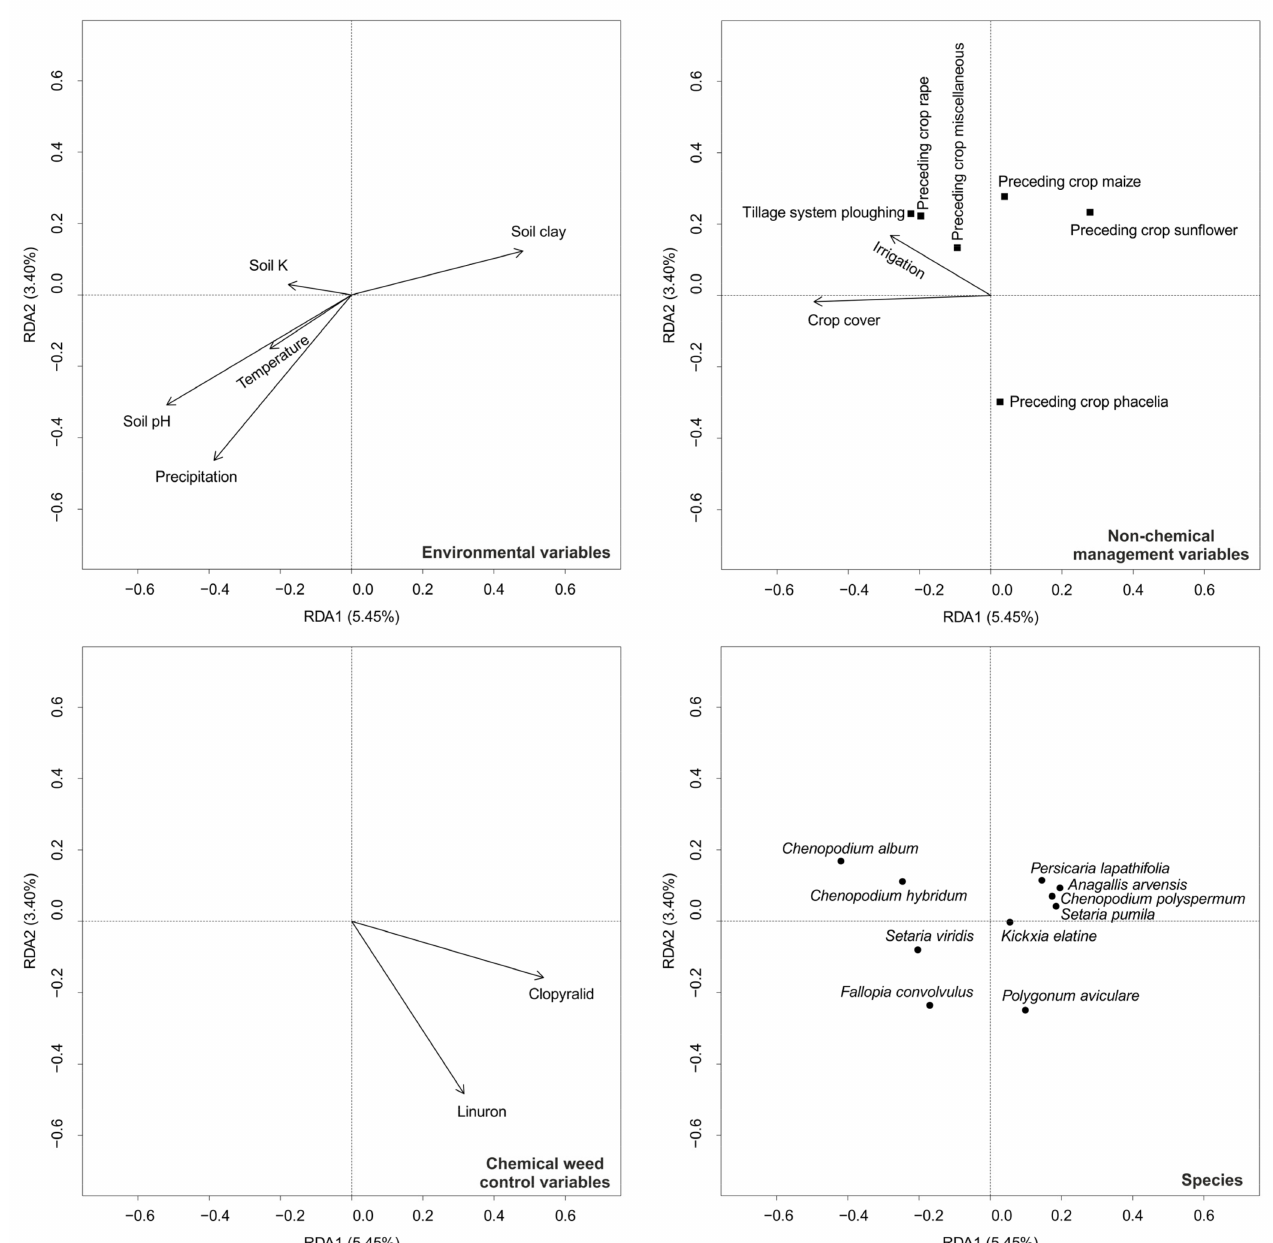
Figure 4. Ordination diagrams of the reduced RDA model containing the 18 significant explanatory variables and the species in the broad-scale survey (BS). Only the species with the highest weights on the first two RDA axes are